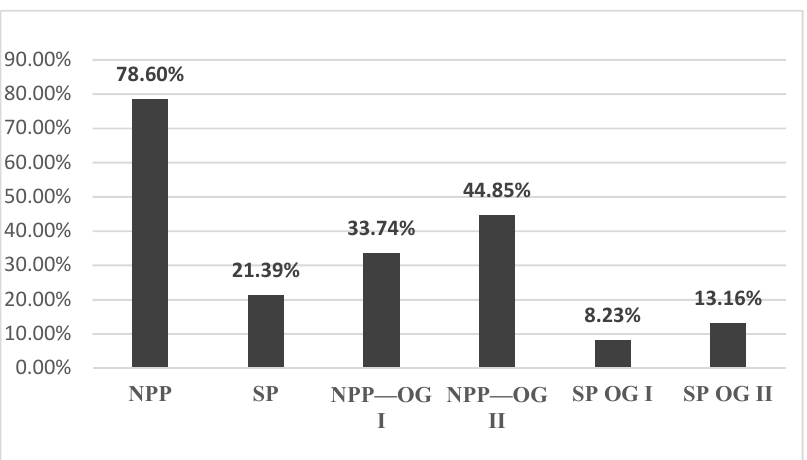
Figure 4. The total number of hospitalized patients diagnosed with cervical lesions by PAP test and colposcopy in the year before the pandemic and the year of the SARS-CoV-2 pandemic. OG: Obstetrics and Gynecology Clinic. NPP: non-pandemic period; SP: SARS-CoV-2 period.